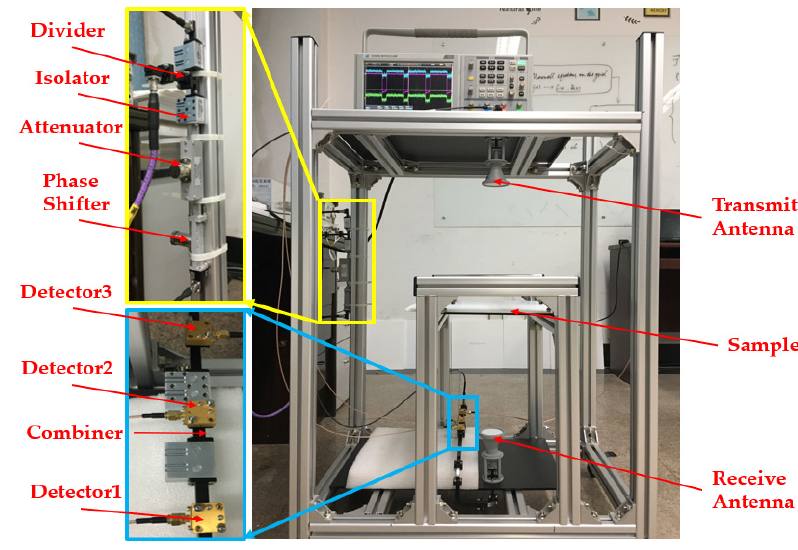
Figure 9. Photograph of the test